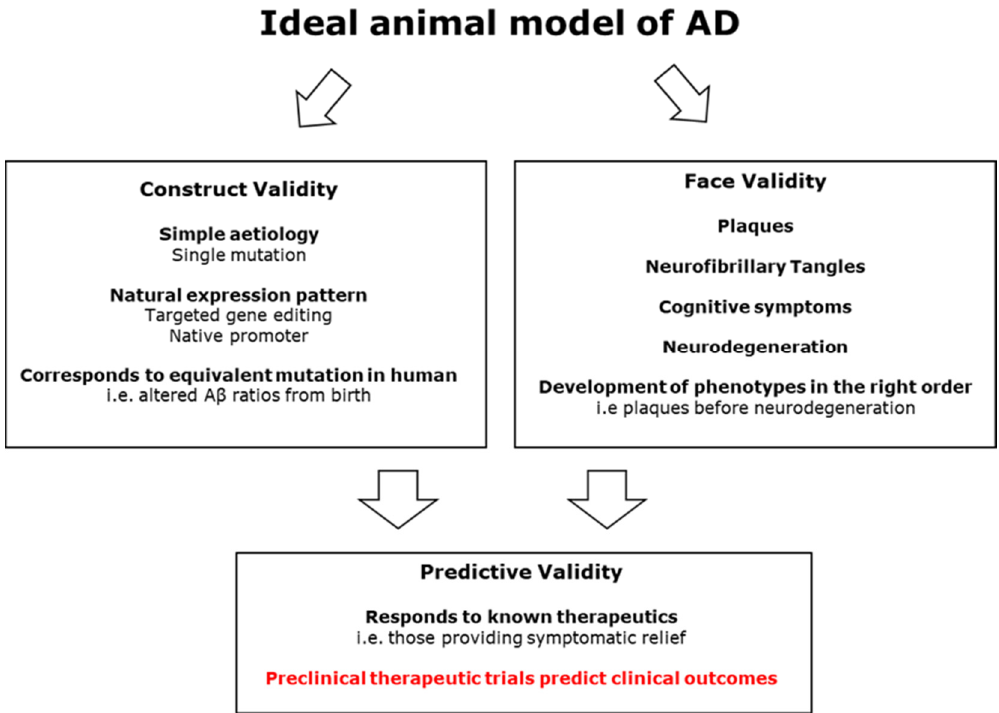
Figure 3. A diagram showing how a model of AD with high face and construct validity is likely to improve predictive validity and lead to effective therapies.